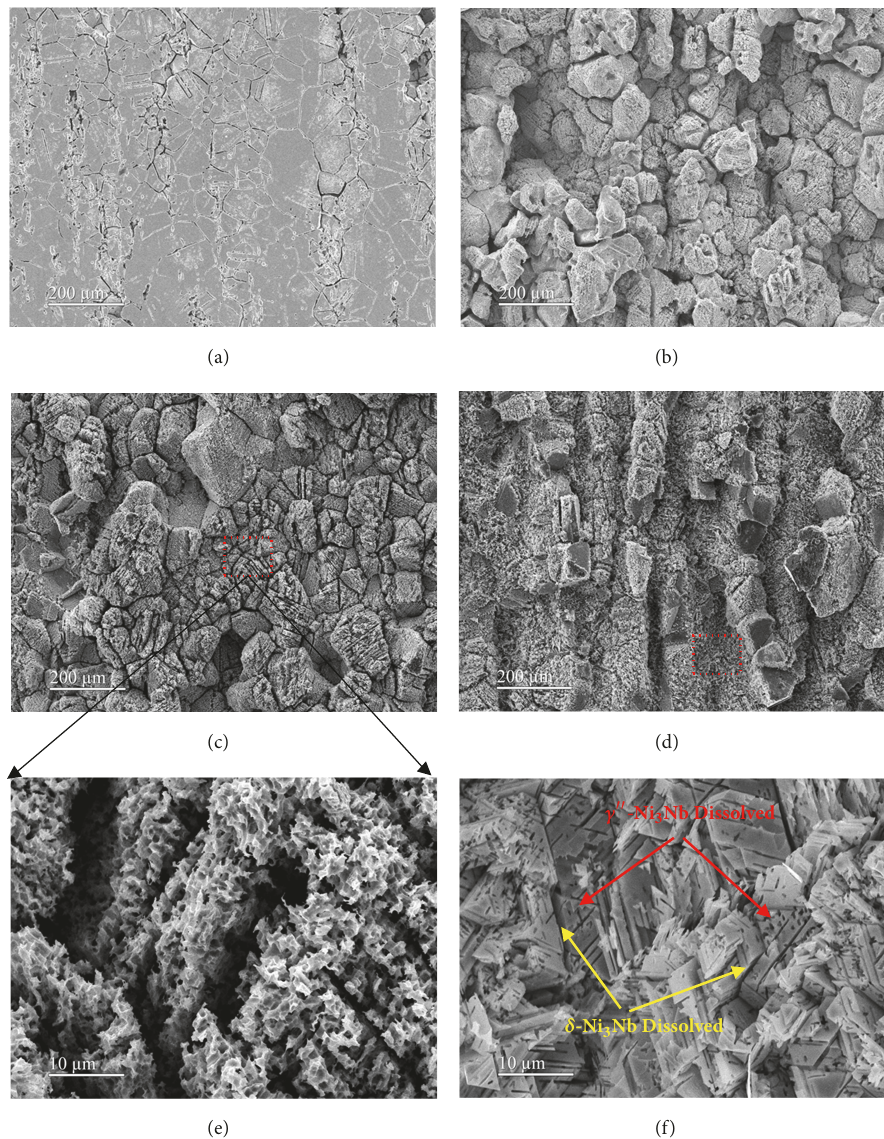
Figure 6: SEM morphologies showing the microstructure of Alloy 625 after aging for (a) 0h; (b) 40h; (c),(e) 200h; and (d),(f) 1000h.